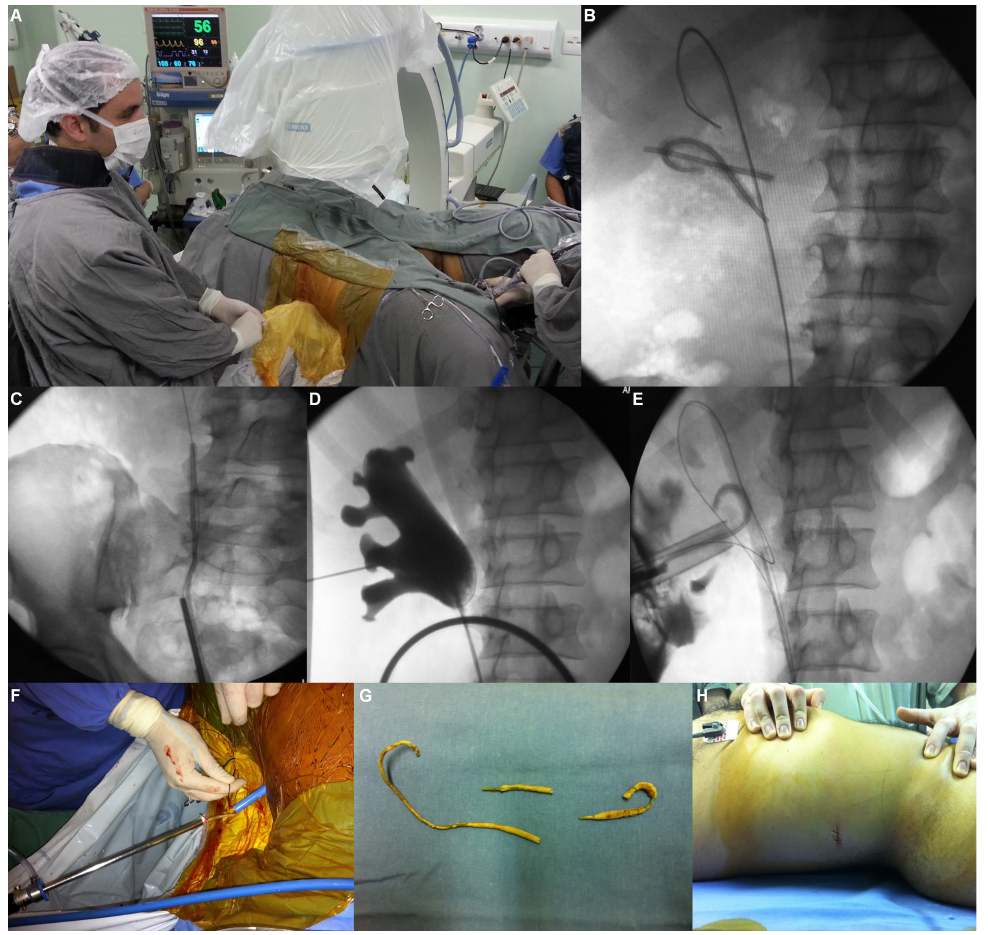
Figure 1 - Image series showing combined approach with Galdakao-modified Valdivia position for removal of encrusted fragmented stent. A) Galdakao-modified Valdivia position. Percutaneous access under biplanar fluoroscopic guidance. B) Guidewire placed retrogradely in the upper calyx. Note two stent fragments located in the kidney. C) Semirigid ureteroscopy. Notice distal stent fragment. D) Retrograde pyelography with 6 Fr ureteral catheter placed into the pelvis and lower calyx puncture. E) Stent fragments retrieval with stone grasping forceps. F) Encrusted stent fragment removal through Amplatz® sheath. G) Completely encrusted stent fragmented in three parts. H) Incision after percutaneous